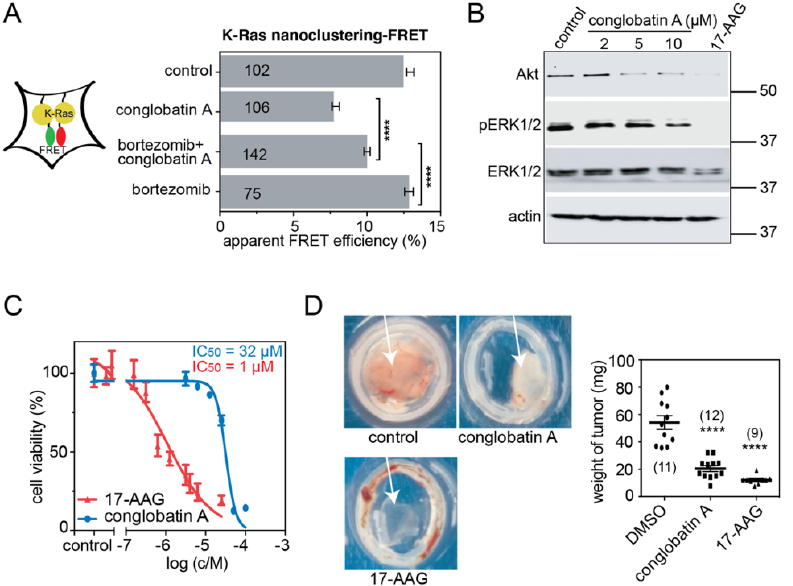
Figure 2. Conglobatin A inhibits Ras signaling, and cell- and microtumor-growth. ( A ) K-RasG12V nanoclustering-FRET in HEK cells co-transfected with mGFP- and mCherry-tagged K-RasG12V. The cells were pretreated with the DMSO vehicle control or 1 μ M bortezomib for 2 h. Then, media containing conglobatin A or the vehicle control were added to the cells, to a final concentration of 2 μ M or 0.1% DMSO, respectively. The cells were fixed after 24 h of this treatment. The numbers in the bars indicate the number of analyzed cells; n = 3 independent biological repeats. ( B ) Western blots of MDA-MB-231 cells that were treated with either 0.1% DMSO vehicle control or with the indicated concentrations of conglobatin A. In total, 2 μ M 17-AAG served as the positive control. All of the drug treatments were for 24 h; n = 2 independent biological repeats. ( C ) 2D cell proliferation dose response curve of conglobatin A or 17-AAG, tested on MDA-MB-231 cells for 72 h; n = 2 independent biological repeats. ( D ) Microtumor formation of MDA-MB-231 cells on chicken CAM. The cells were treated with 0.1% DMSO vehicle control, 10 μ M conglobatin A or 5 μ M 17-AAG for 5 days; n = 3 independent biological repeats. **** p < 0.0001.